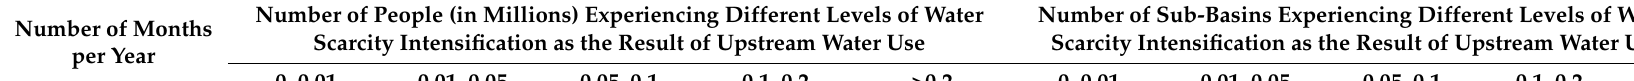
Table 1. The number of people (in millions) and the number of sub-basins that experience different levels of water stress intensification due to upstream water withdrawal. The UN adjusted population count for the target year obtained from the Center for International Earth Science Information Network (CIESIN) [24] was